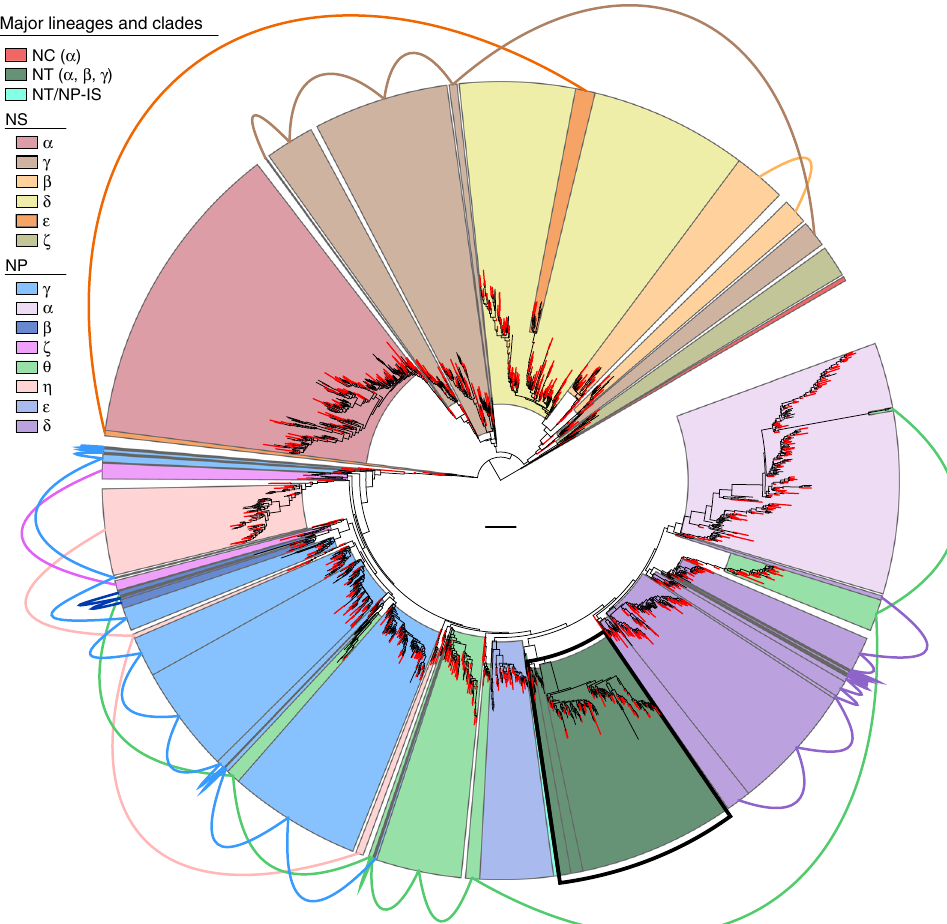
Fig. 3 Effect of chimeras on the archaeal amoA phylogeny. The tree is based on 2203 sequences (591 aligned positions) representing our database prior to chimera fi ltering (35,372 sequences), clustered at 96% sequence identity. Major clades correspond to those de fi ned based on the best tree inferred from the curated database (Fig. 1) and are colour coded as indicated in the fi gure. Framed areas with the same colour connected by lines indicate sequences from the same correct clade that are polyphyletic in this tree. Red branches represent chimeric sequences. The black-framed area highlights the misplacement of lineage NT ( Ca . Nitrosotaleales) within lineage NP ( Nitrosopumilales ). The scale bar represents 0.2 substitutions per nucleotide position. The tree was calculated with IQ-TREE 80 following the same procedures used to obtain the best tree based on the curated database (see